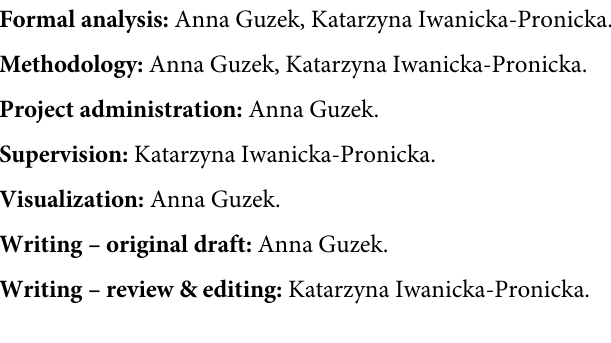
S6 Table. 1 . Basic statistics describing the DDT test results for the RE (top) and LE (bottom) in study group”S” and control group”C”, by age group. 2 . Basic statistics describing the FPT test results in study and control groups (”S” and”C” respectively), by age group. 3 . Basic statis- tics describing the ASPN-S test results in study and control groups (”S” and”C” respectively), by age